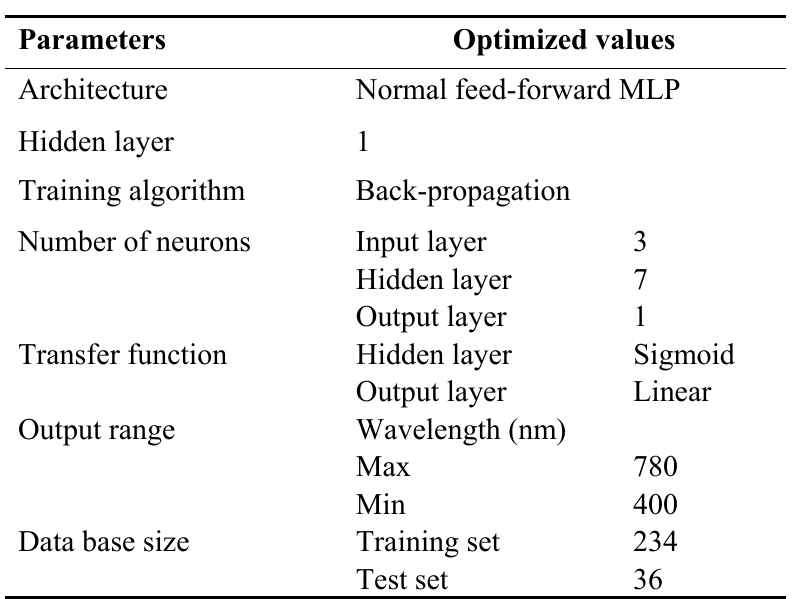
Table 1. ANN optimized